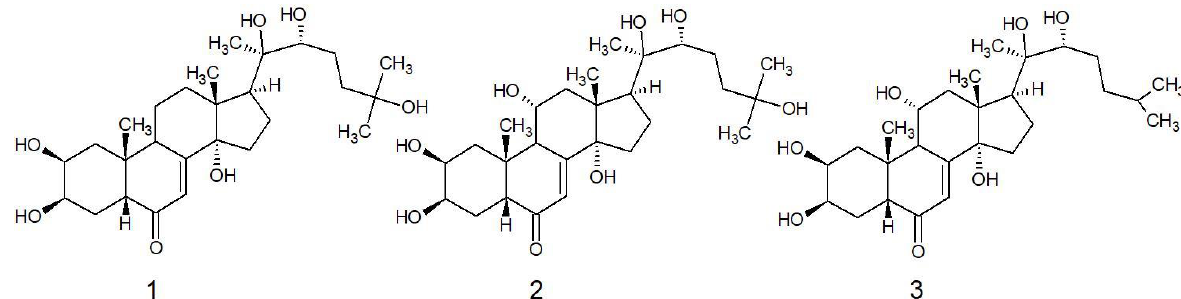
Figure 1. Structures of compounds 1 – 3 isolated from the stem bark of Vitex doniana . 1 is 20-hydroxyecdysone, 2 is turkesterone and 3 is ajugasterone C. Ajugasterone C was previously reported in this species.